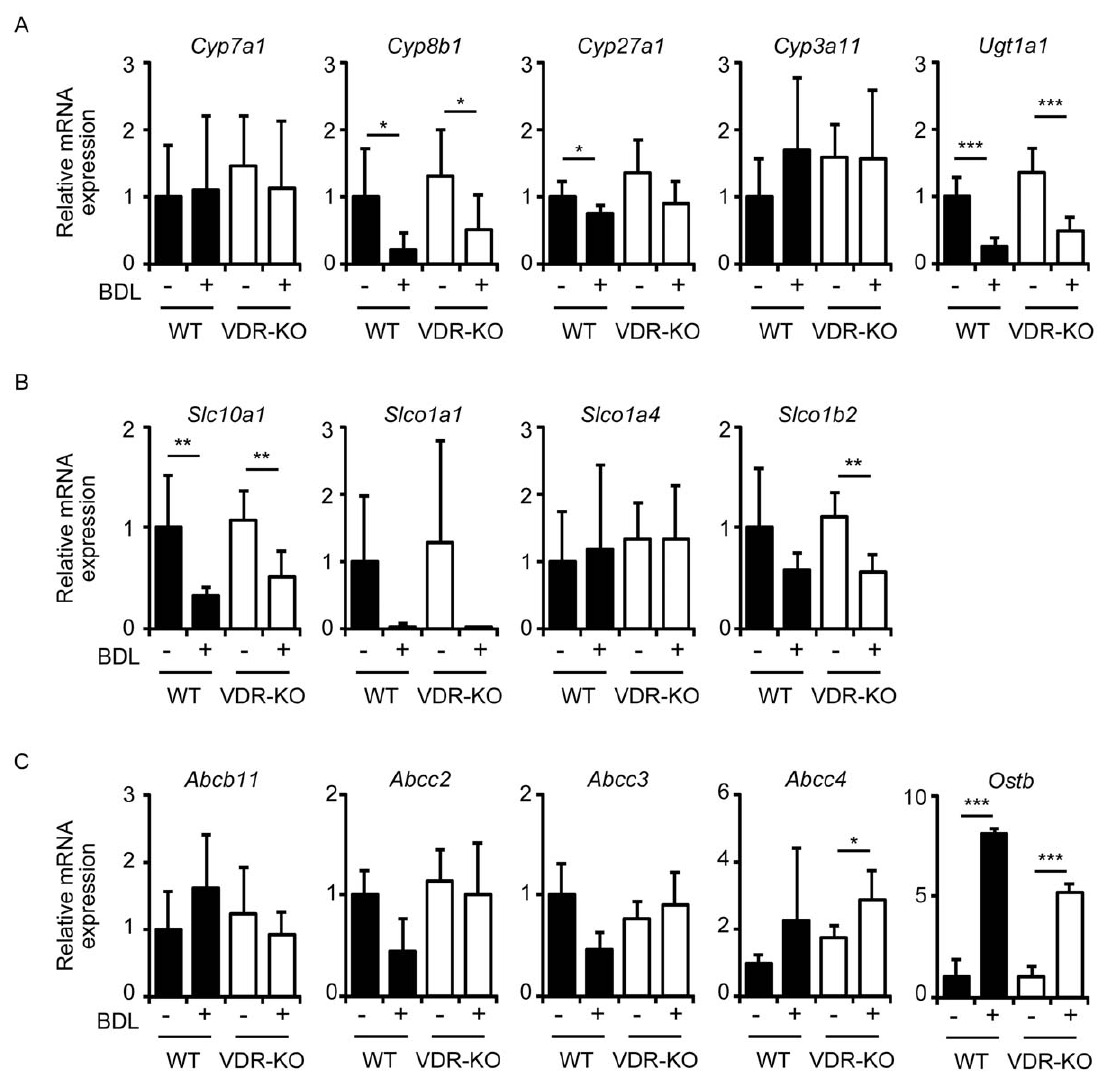
Figure 2. Hepatic mRNA expression of genes involved in bile acid and bilirubin metabolism. mRNA expression of enzymes (A), uptake transporters (B) and efflux transporters (C) were examined. Total RNAs were prepared from the liver of wild-type mice (WT) and VDR-null mice (VDR- KO) 7 days after sham operation or BDL. The values represent means 6 S.D. * p , 0.05; ** p , 0.01; *** p , 0.001.